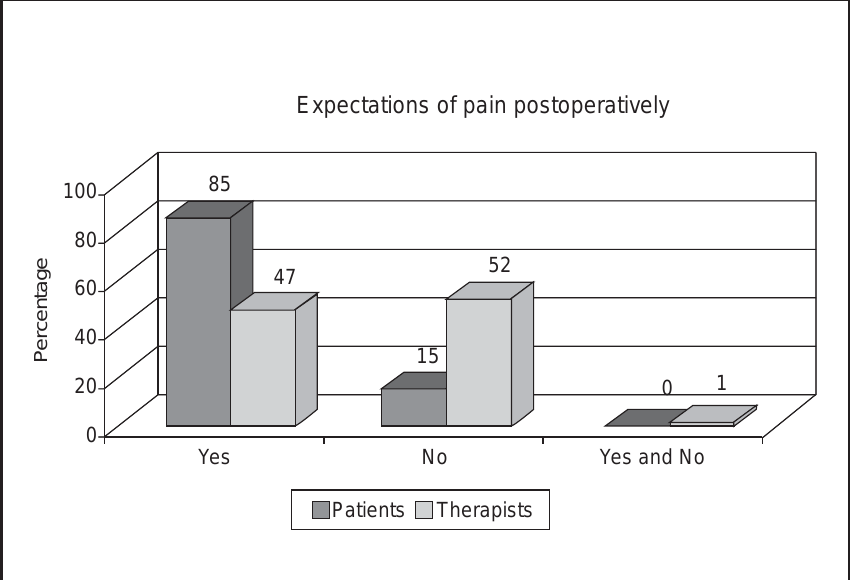
Figure 1: Pain expectancies following spinal